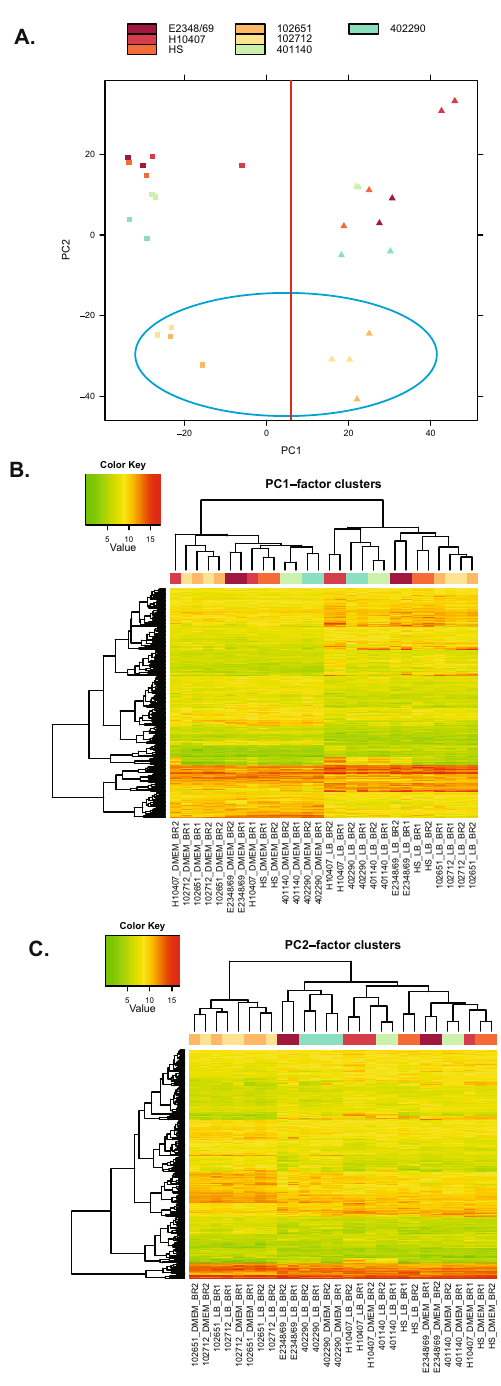
Figure 3. Analysis of the LB and DMEM RNA-Seq samples from all of the E. coli isolates. ( A ) Principal component (PC) analysis of the normalized expression values of the LB and DMEM samples for ETEC isolate H10407, non-pathogenic isolate HS, EPEC isolates E2348/69 and 402290, and the EPEC/ETEC hybrid isolates 102651, 102712, and 401140. Each of the RNA-Seq samples is indicated by a different color in the legend at the top of the panel. The squares represent the DMEM samples and the triangles represent the LB samples. The red line separates all of the LB and DMEM samples, and the blue circle identifies the samples of the LT + EPEC/ETEC isolates 102651 and 102712. ( B) Hierarchical clustering of 520 gene clusters of PC1 and ( C) 263 gene clusters of PC2. The heatmaps in these two panels display the normalized gene expression values of the LS-BSR gene clusters that were present in all of the genomes and had the greatest deviation in their expression